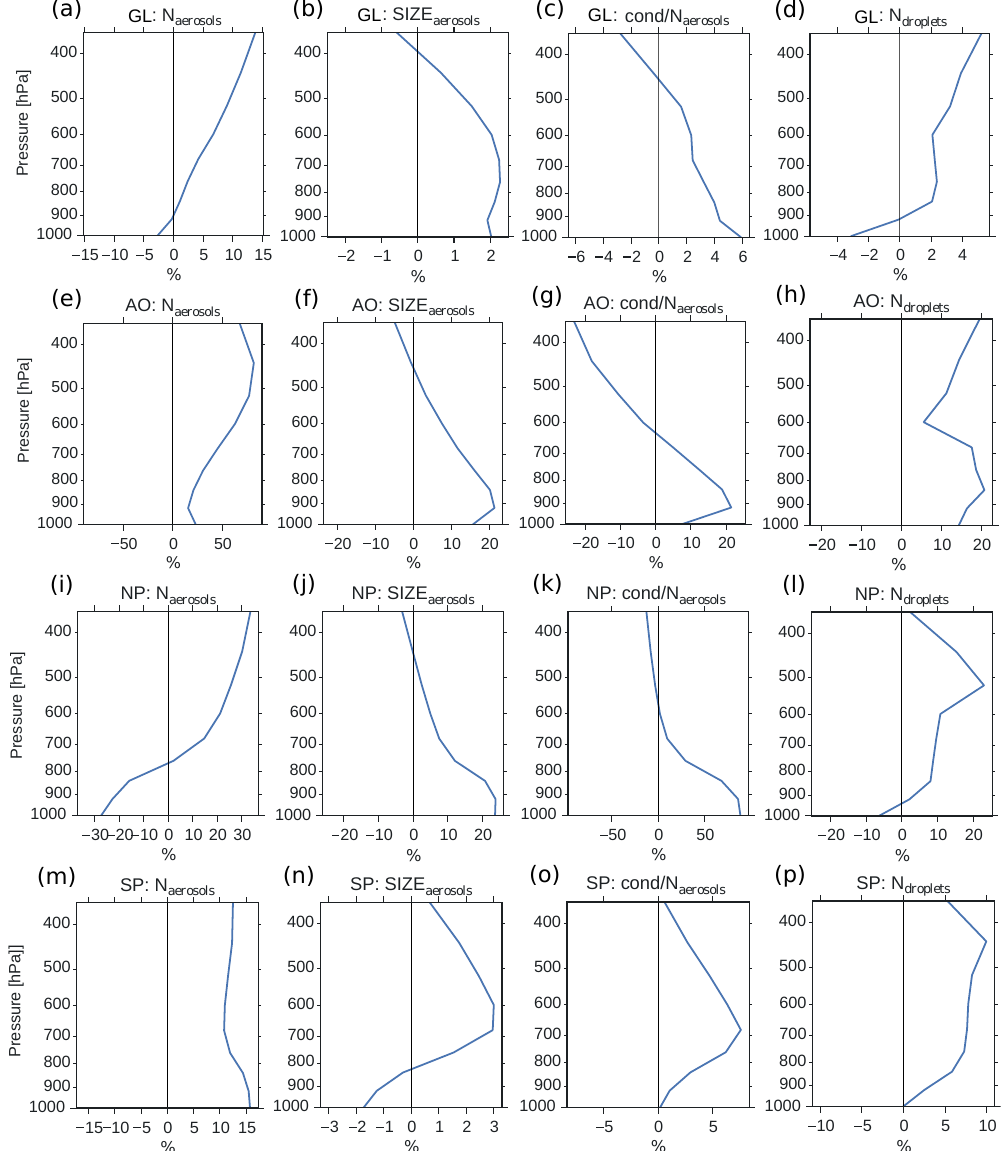
Figure 9. Vertical profiles of annual averaged changes in aerosol number concentration (a, e, i, m) , aerosol size (b, f, j, n) , aerosol condensate divided by the aerosol number concentration (c, g, k, o) and CDNC (d, h, l, p) on a global mean (GL) and in the three different regions from Fig. 8 (Arctic Ocean – AO, North Pacific – NP and South Pacific – SP), when switching from PD to PI oxidants in the PI simulation. The mean size of the aerosols in panels (b, f, j, n) is calculated as a mean of the number mean radius of all mixtures in the model, weighted by the number of aerosols in each